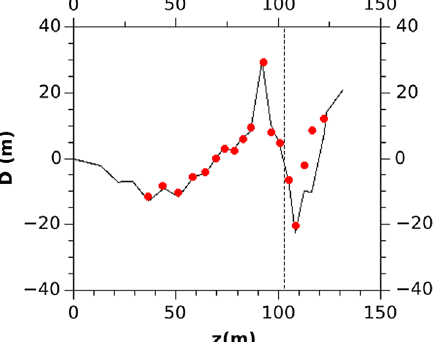
FIG. 3. Measured dispersion function with dispersion tailoring. The red dots are the measured points, and the black curve is the model prediction. The dashed vertical line indicates the location of the IP. The position s ¼ 0 corresponds to the beginning of the first dipole in the HEBT ninety-degree arc.